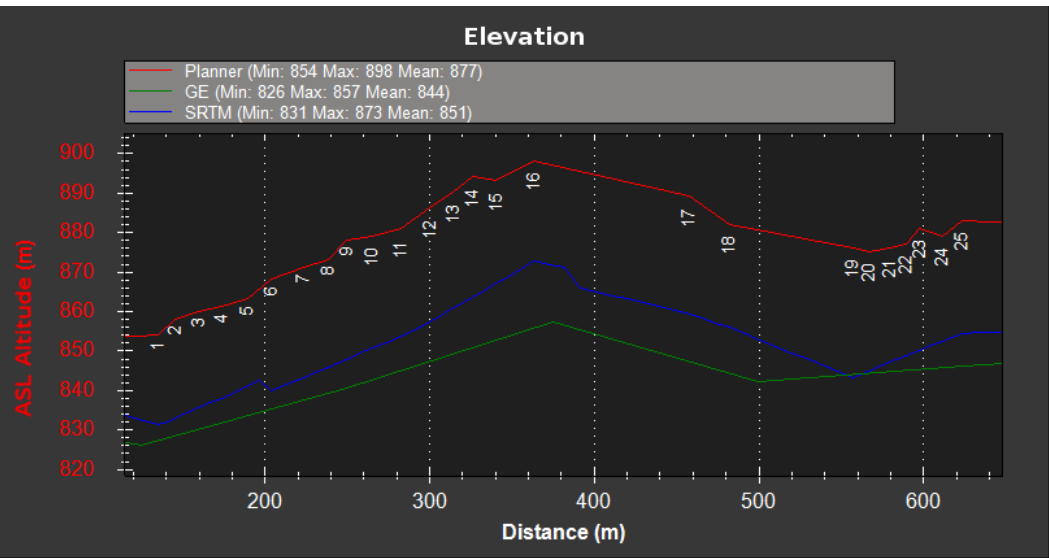
Figure 8. Hill flight plan. The figure shows the flight plan for the hill video sequence: the first slope is between Waypoints 1 and 16 and the second between Waypoints 19 and 25.